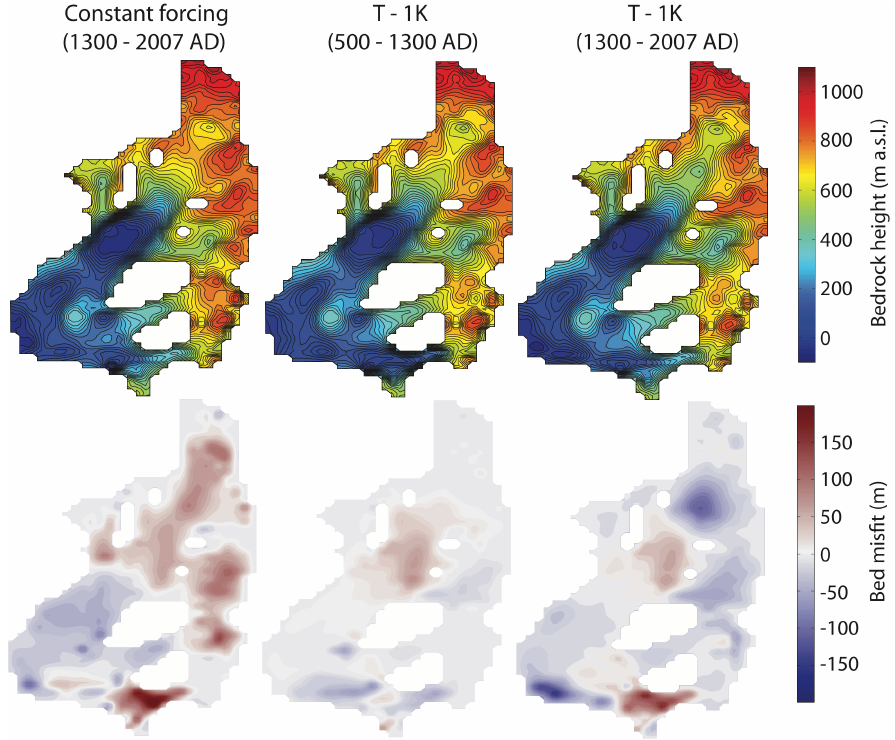
Fig. 12. Final recovered basal topography (1st row) and the corresponding bed discrepancy (2nd row) with regard to the φ = 13 ◦ experiment using a constant climate forcing for 1300–2007AD (1st column) and negative temperature perturbation for 500–1300AD (2nd column) and 1300–2007AD (3rd